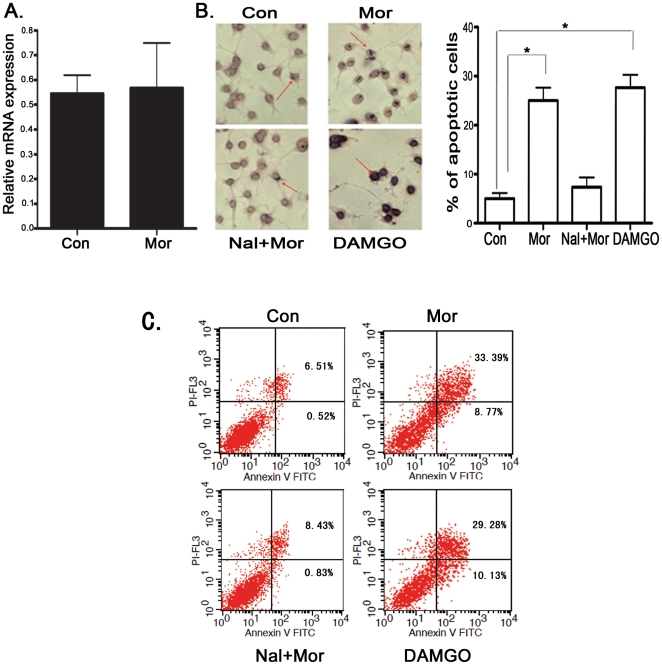
Morphine induces microglia apoptosis in a μOR dependent
manner.(A) Morphine could not induce the expression of TLR9 in μOR KO
microglia. μOR deficient microglia cells were treated morphine at 10
µM for 12 hr and the expression of TLR9 in mRNA levels determined
by quantitative real time RT-PCR as in Fig. 1A. Wild type microglial cells
were treated with 10 µM morphine with or without 20 µM
naloxone pretreatment. Another group of cells were treated with 10
µM DAMGO alone for 24 hr. Apoptotic cells were examined as in
Fig. 3. (B).
Representative light microscopic images showed TUNEL-positive microglia
(red arrow head). Magnification 200×. Results represent mean
± SD from three independent experiments. *
p<0.01 compared with indicated groups. (C).
Apoptotic cells were analyzed by flow cytometry. These results are
representative of three independent experiments.